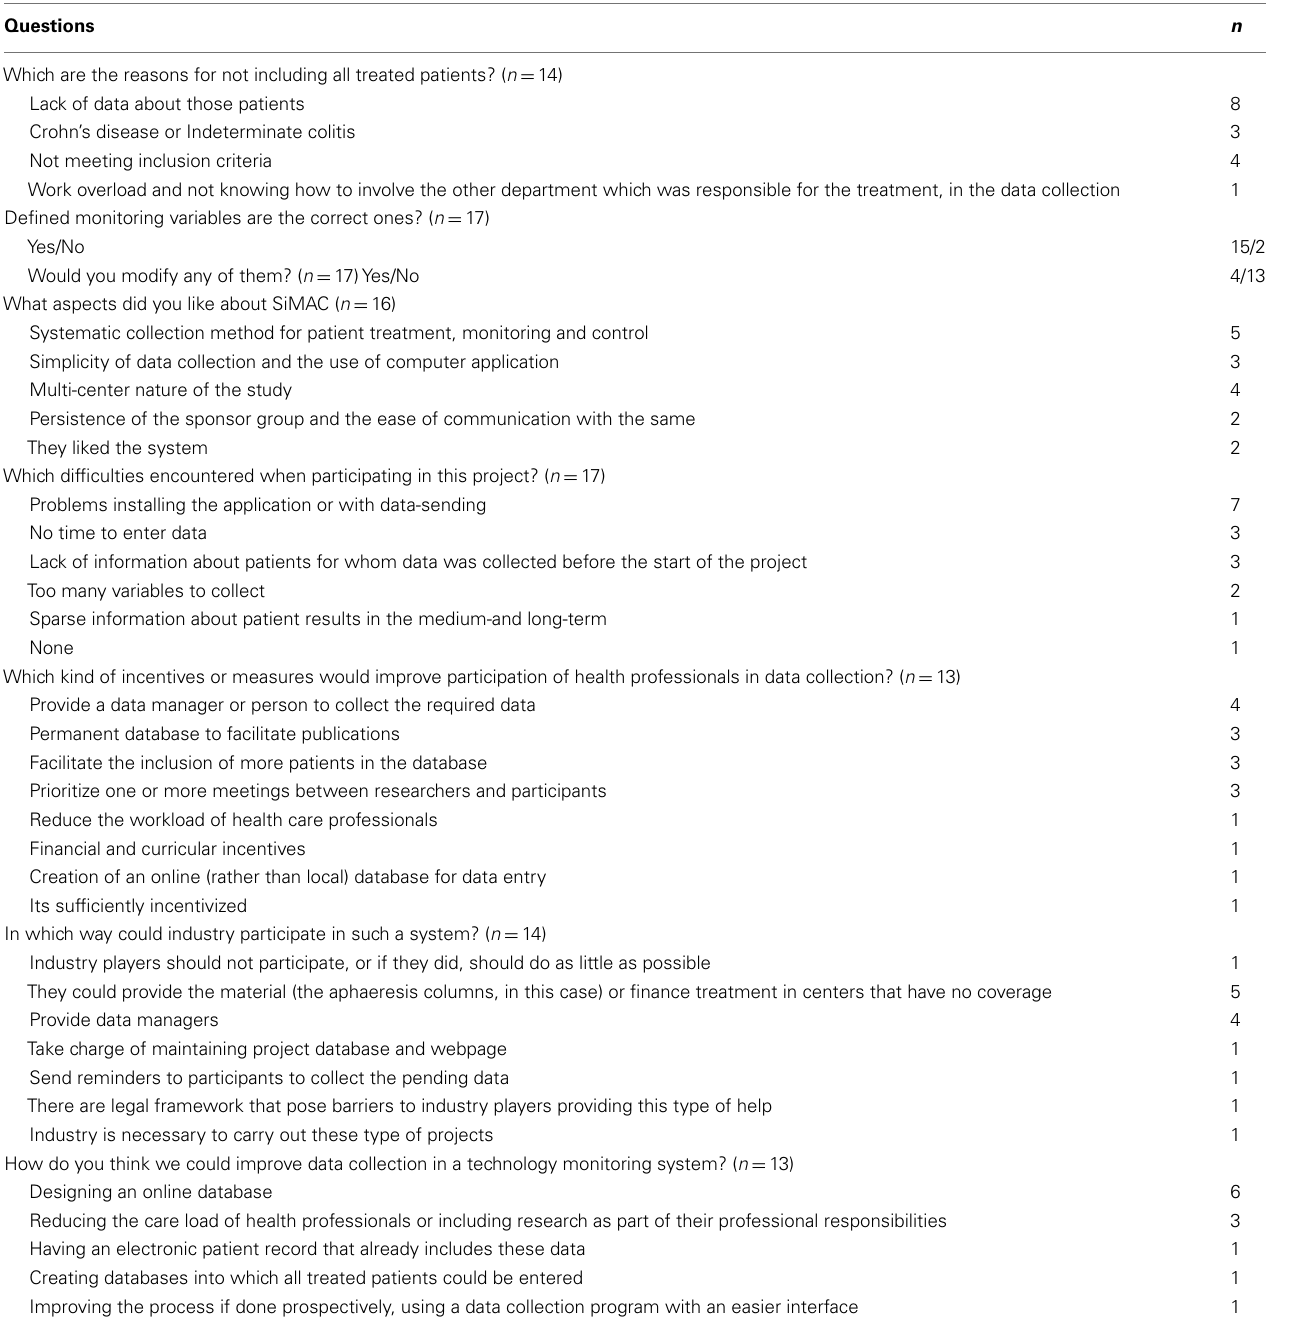
Table 3 | System for monitoring aphaeresis in ulcerative colitis assessment by